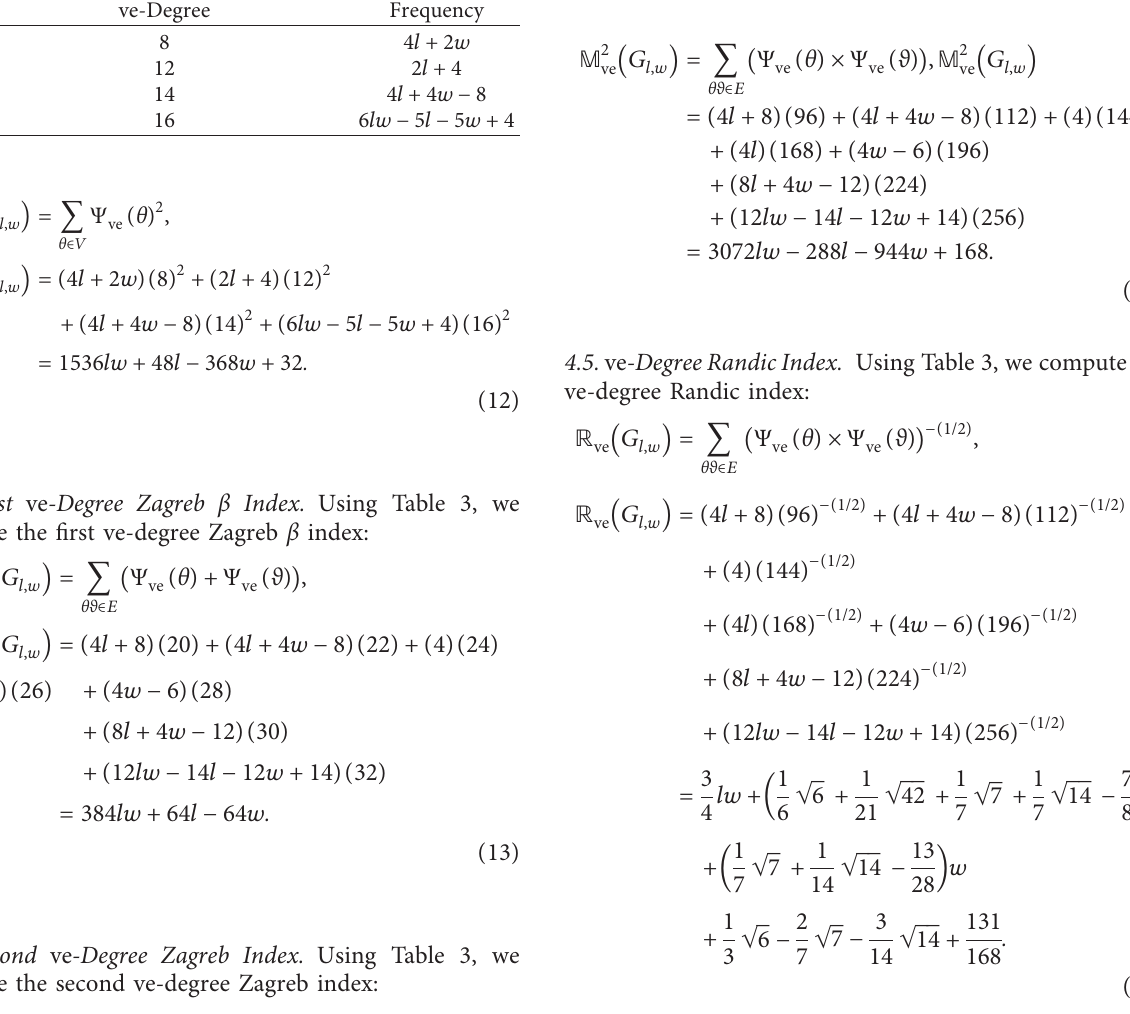
Table 2: ve-Degree of G